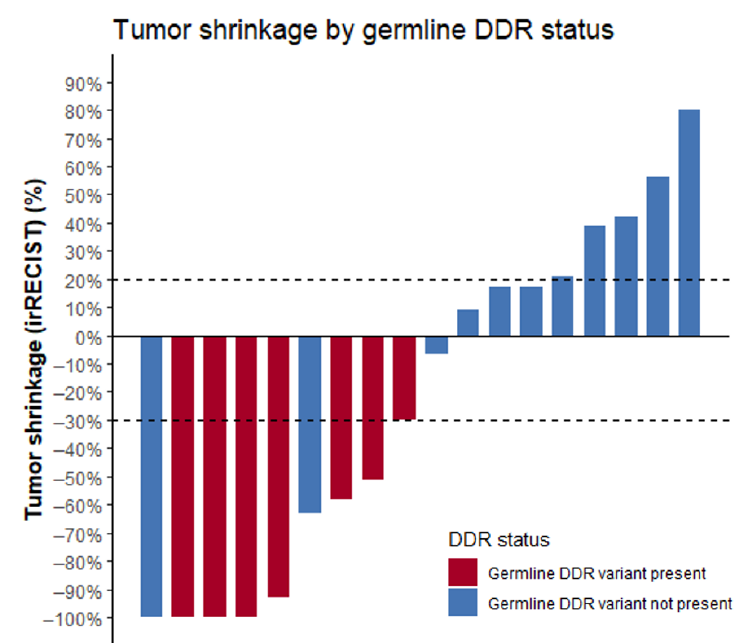
Figure 2. Waterfall plot displaying the best response to ICPIs according to irRECIST criteria. Note: two patients without DDR alterations were not included in this figure as precise tumor shrinkage was not available. Best response was defined as “clinical benefit”. Abbreviations: ICPIs = immune checkpoint inhibitors, DDR = DNA damage response. Table 2. Best response according to irRECIST in the patient groups with or without germline DDR variant. Germline DDR Status